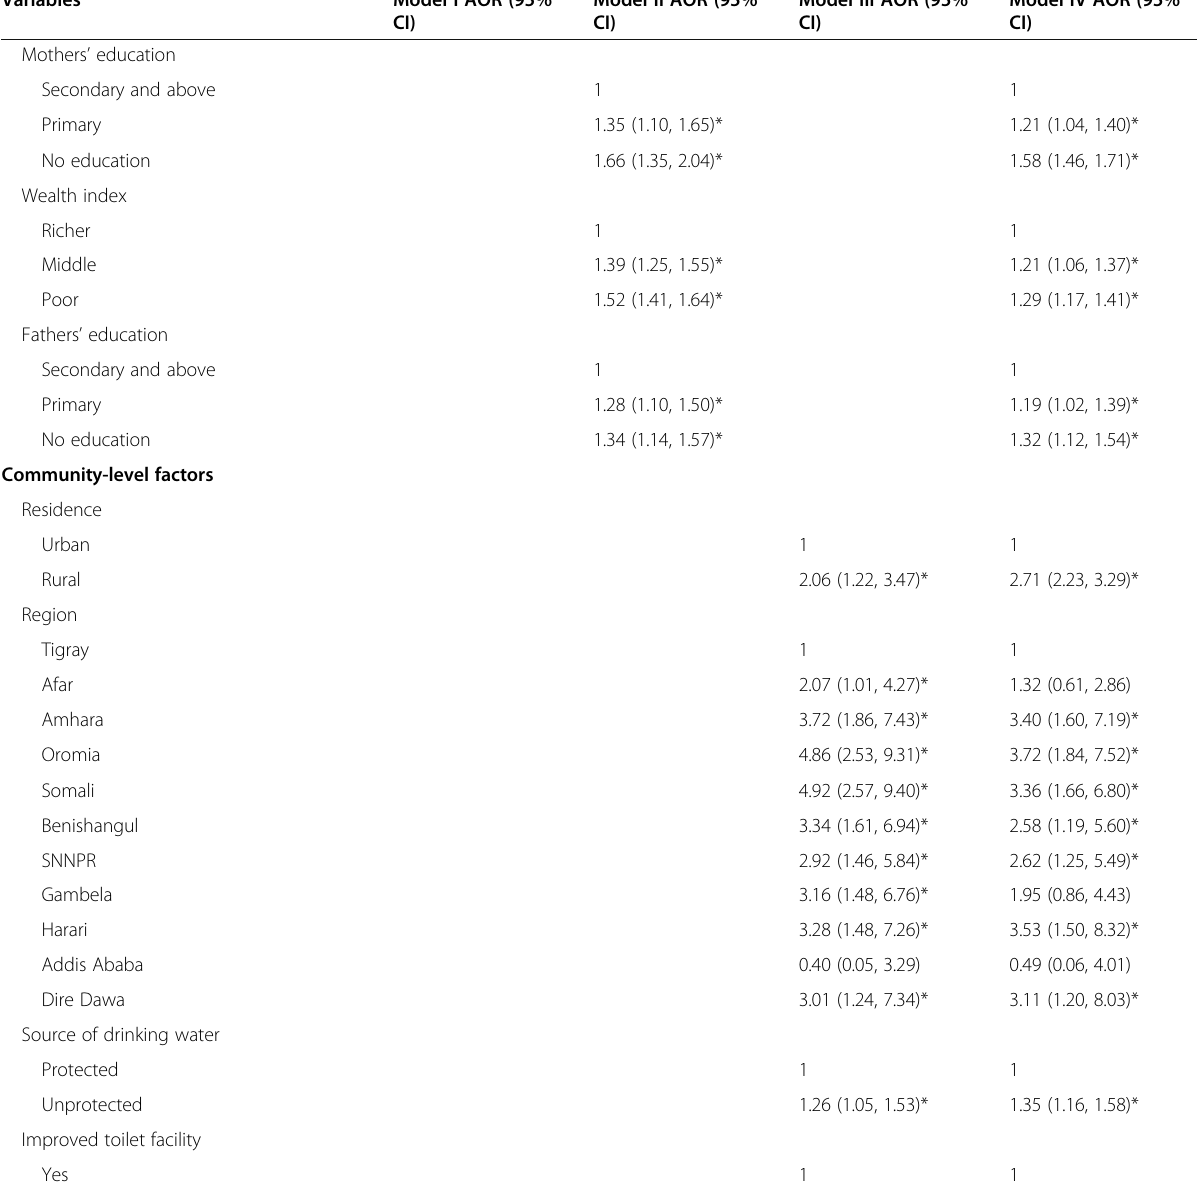
Table 3 Multilevel logistic regression analysis for risk factors of neonatal death in Ethiopia, EDHS 2016 data (Continued)